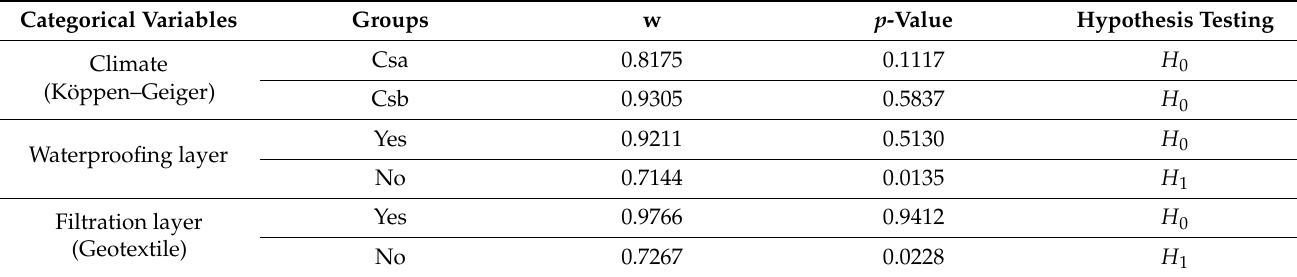
Table A3. Shapiro–Wilk test results for peak attenuation (%).